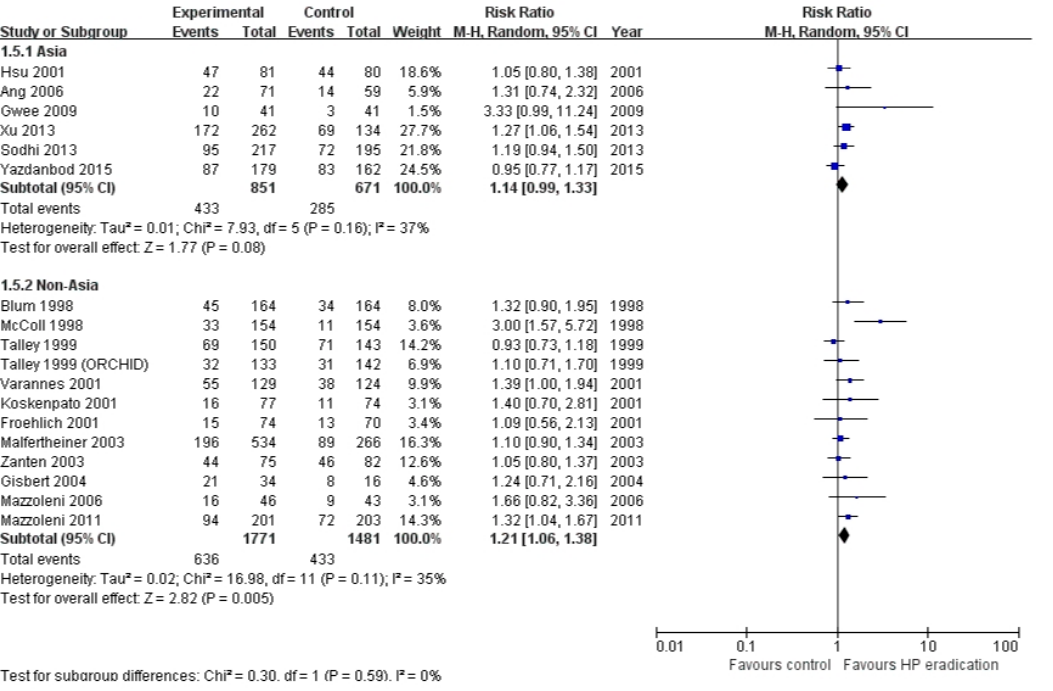
Figure 5. Subgroup analysis by geographical region. 1.5.1. studies from Asia, 1.5.2. studies from outside Asia.